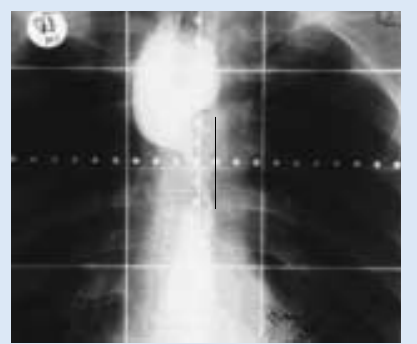
Fig. 1. Simulator film with grid (vertebral length = 2.5 vertebrae = 6.25 cm, grid length = 5 cm).